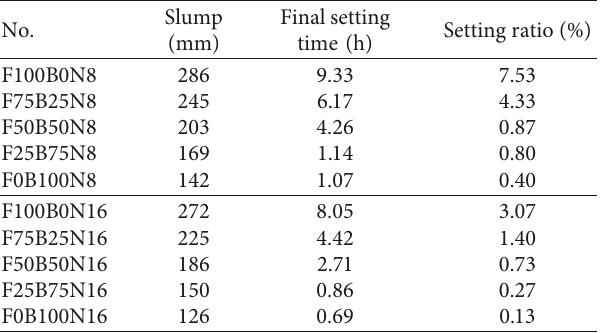
Table 3: Setting time, flow ability, and setting ratio of geopolymer